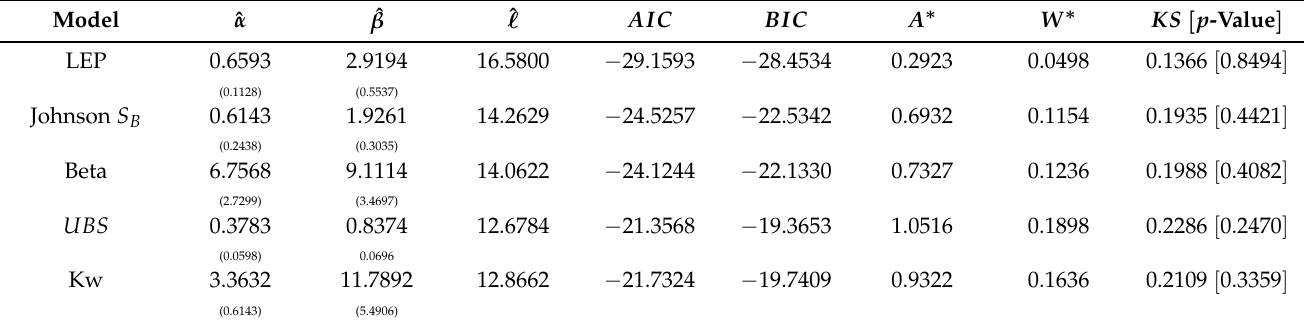
Table 2. The results of the fitted models for the maximum flood level